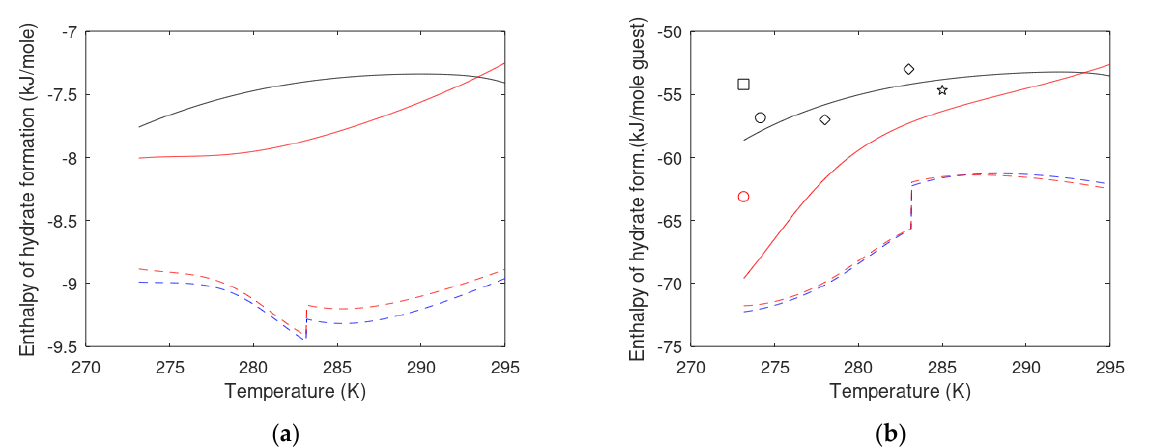
Figure 12. ( a ) Enthalpies of hydrate formation in units kJ/mole hydrate. Red solid is for pure H 2 S hydrate and black solid is for pure CH 4 hydrate. Dashed blue is for hydrate formed from a mixture of 70% CO 2 , 5% CH 4 , 5%C 2 H 6 , and 20%N 2 . Dashed red is for hydrate formed from a mixture of 70% CO 2 , 5% CH 4 , 2%C 2 H 6 , and 23%N 2 . ( b ) Enthalpies of hydrate formation in units kJ/guest molecule in hydrate. Red solid is for pure H 2 S hydrate and black solid is for pure CH 4 hydrate. Dashed red is for hydrate formed from a mixture of 70% CO 2 , 5% CH 4 , 5%C 2 H 6 , and 20%N 2 . Dashed red is for hydrate formed from a mixture of 70% CO 2 , 5% CH 4 , 2%C 2 H 6 , and 23%N 2 . Black square is experimental data for pure CH 4 hydrate from Handa et al. [53]. Black pentagram is experimental data for pure CH 4 hydrate from Rueff et al. [54]. Red circle is experimental data for pure H 2 S hydrate from Yoon et al. [55]. Black diamond is experimental data for pure CH 4 hydrate from Lievois et al. [56]. Black circle is experimental data for pure CH 4 hydrate from Handa et al. [53].